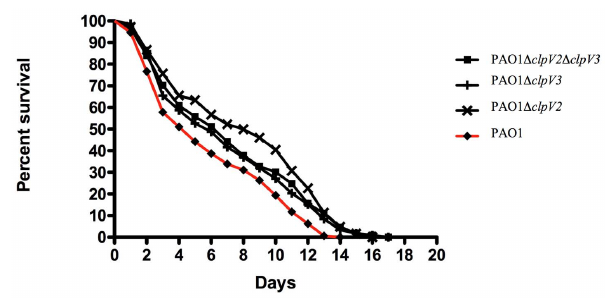
Figure 1. H3-T6SS is required for virulence in C. elegans . C. elegans was infected with PAO1 and isogenic D clpV2 , D clpV3 or D clpV2 D clpV 3 mutants. The resulting C. elegans survival curve is shown for each strain. Evalue , 0.01 (Prism 5 software).